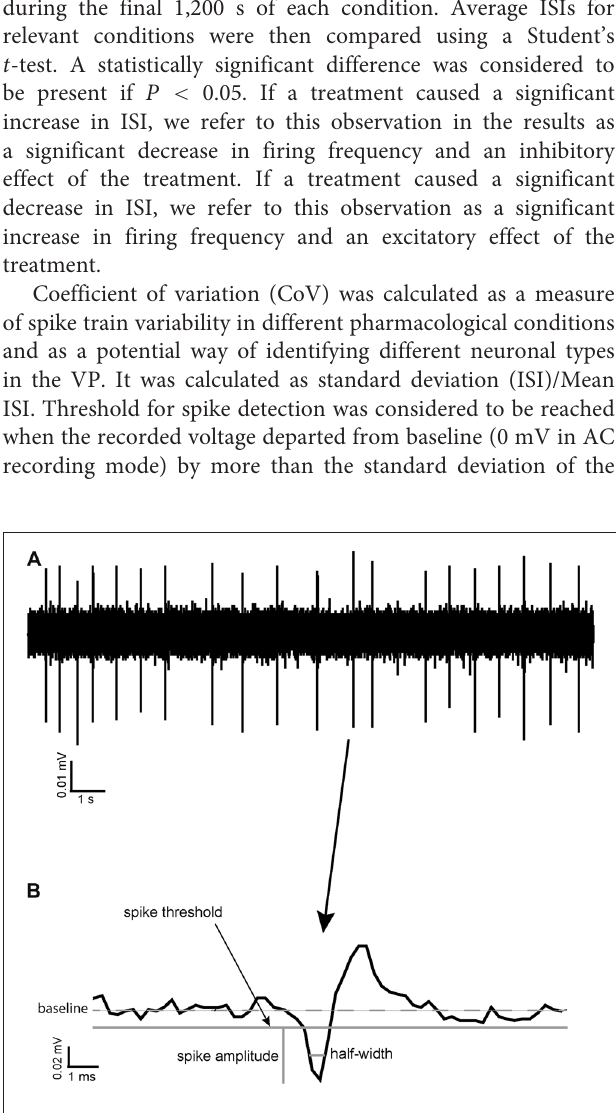
FIGURE 1 | Spike half-width calculation. (A) A raw data trace of tonic neuronal activity measured in the ventral pallidum (VP). (B) An example of a typical spike recorded in the VP with the reference point used for calculation of its spike half-width, halfway between baseline and maximum negative